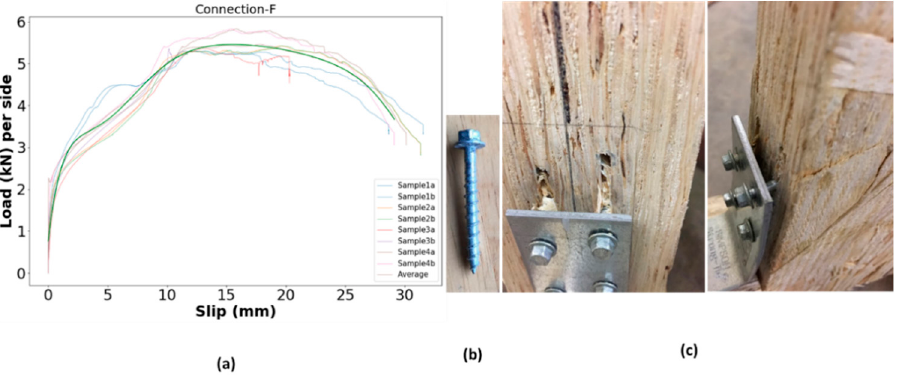
Figure 26. ( a ) Load slip response; ( b ) screw from cut specimen; ( c ) failure mode of Connection-F.